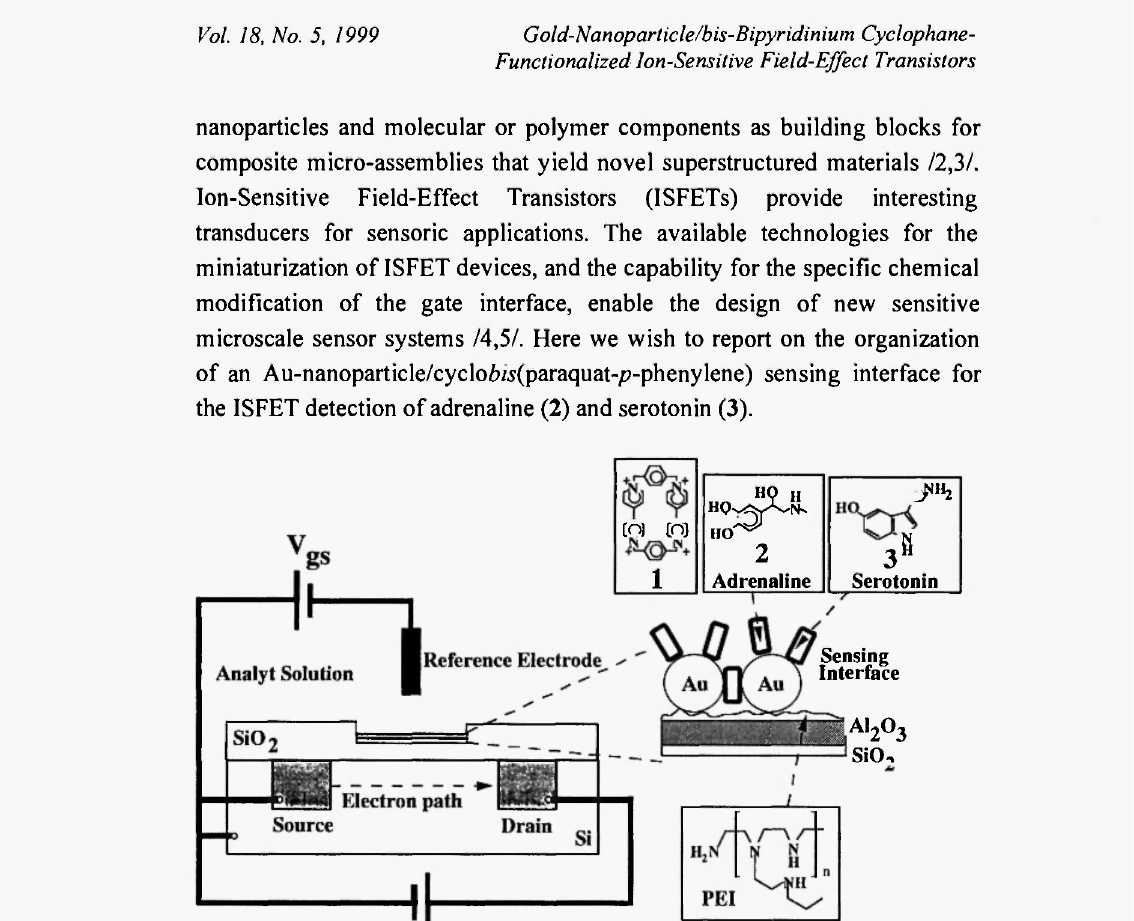
Scheme 1: Schematic configuration of the functionalized ISFET device for sensing of